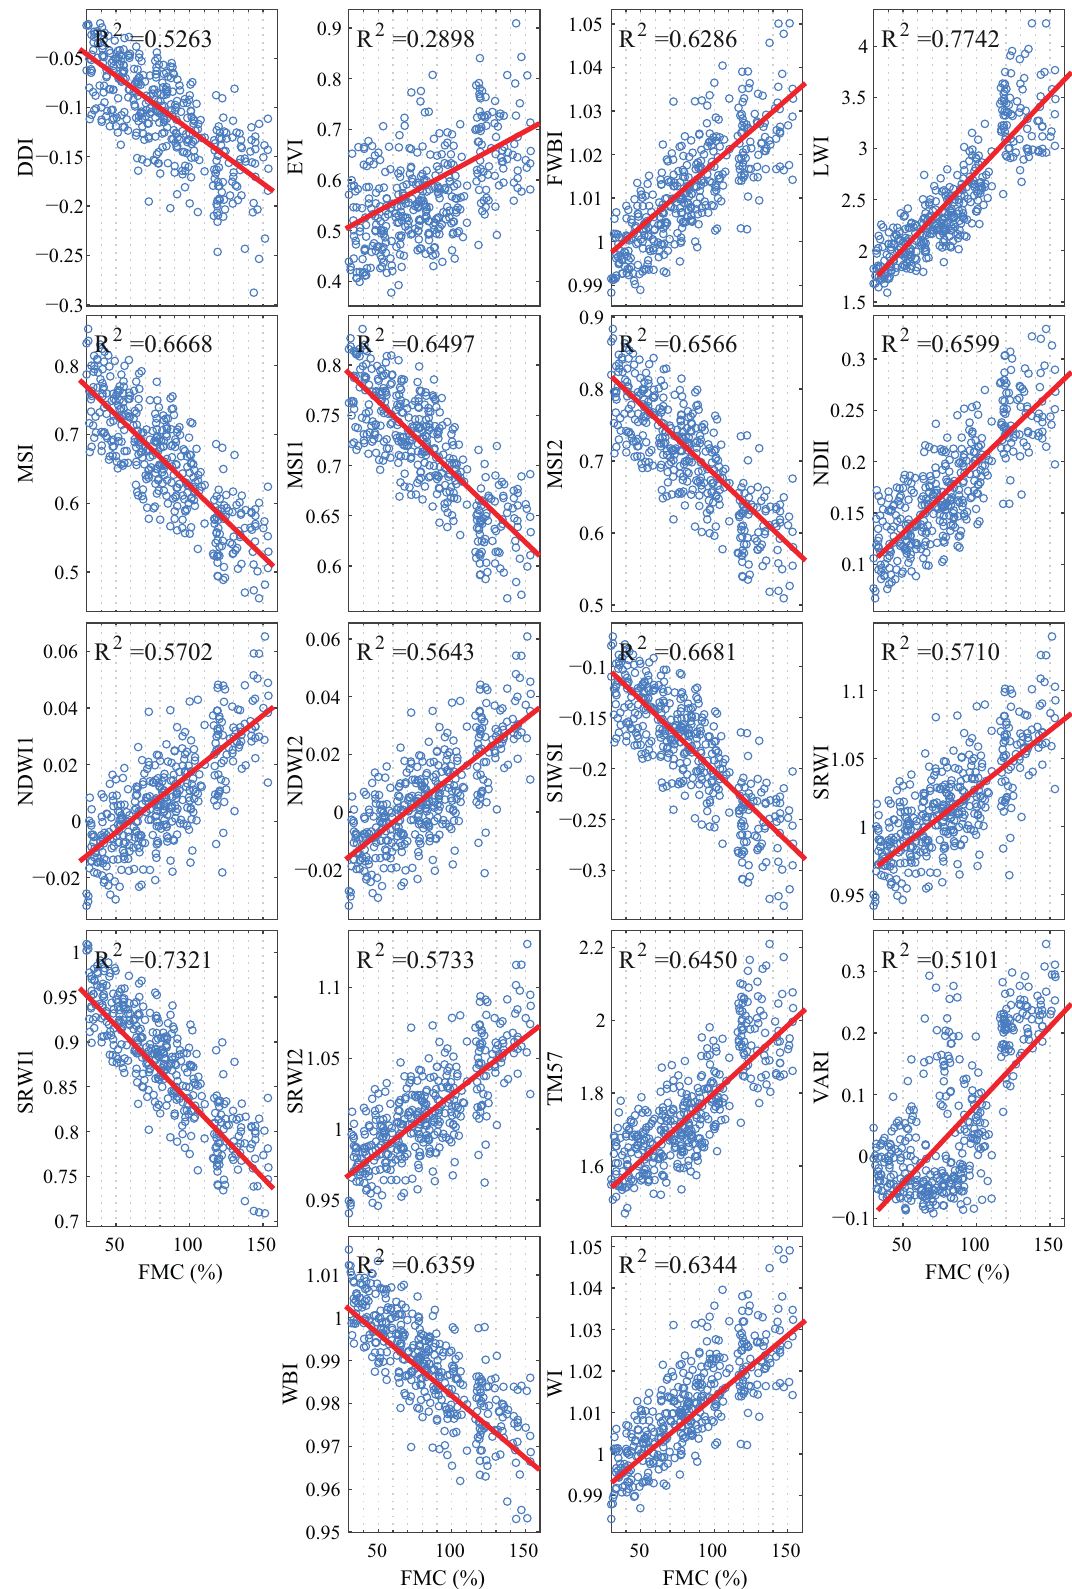
Figure A1. VIs variation as function of Fuel Moisture Content for Pinus radiata